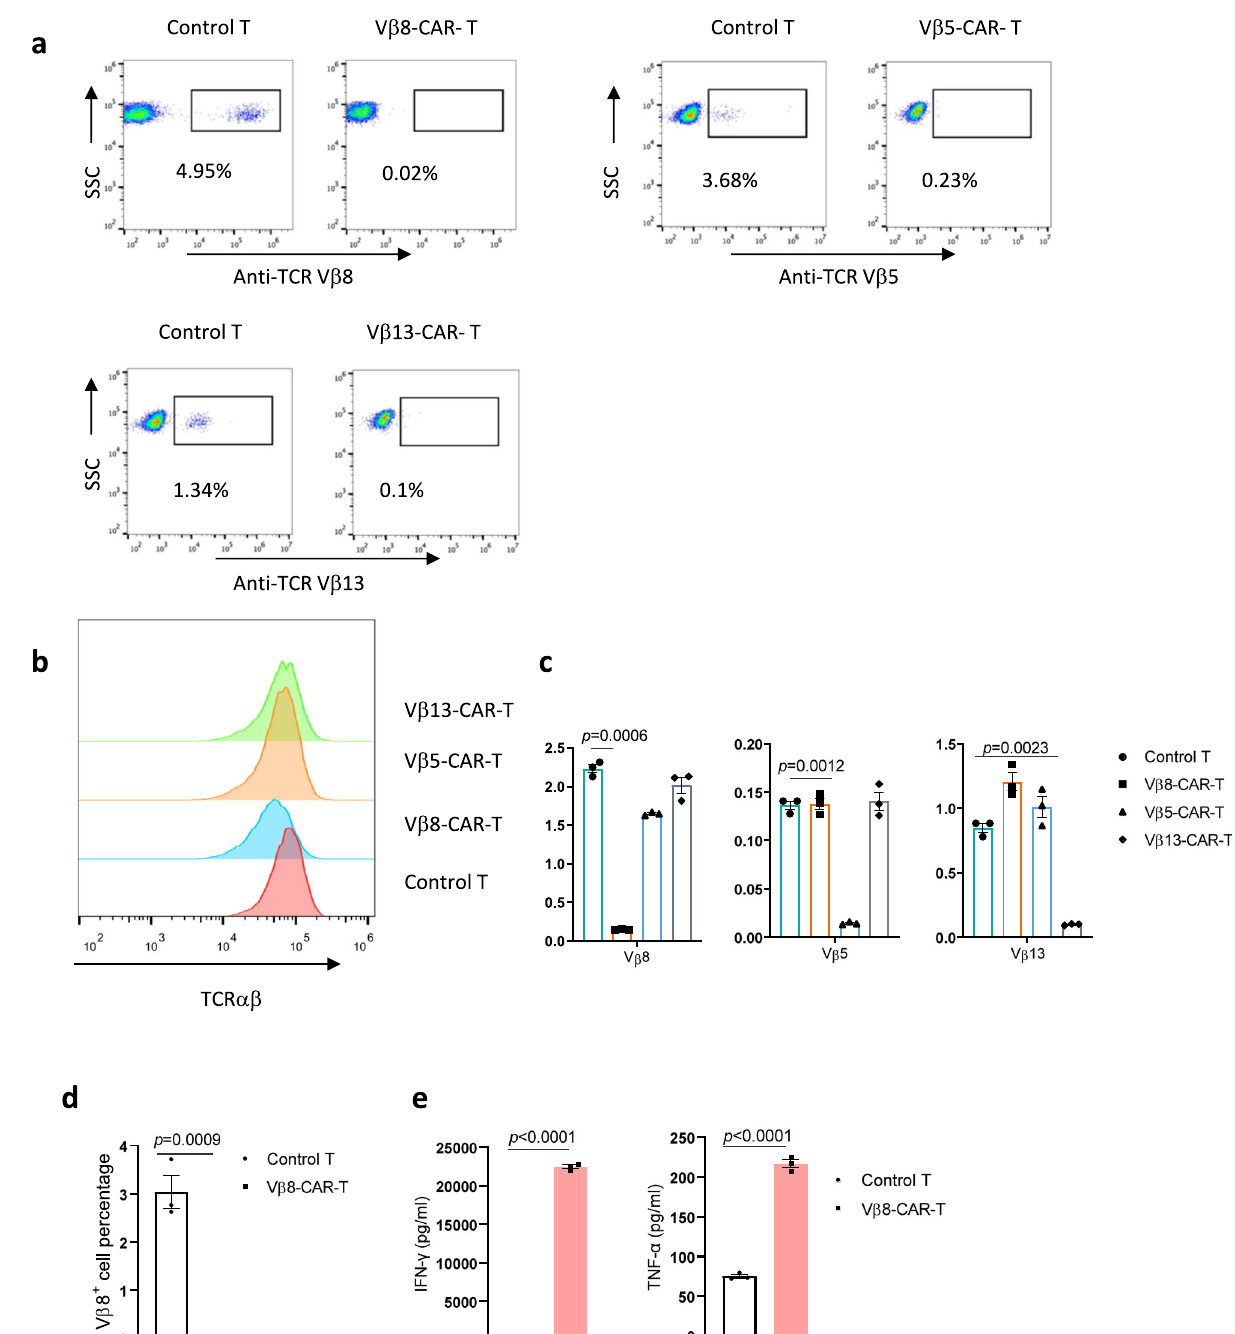
Fig. 1 | V β -speci fi c CAR-T cells speci fi cally eliminated target-positive primary T cells. a – c The expression levels of the indicated TCR V β subtypes ( a , c ) or total TCR αβ ( b )inuntransducedTcellsandV β 8-,V β 13-,orV β 5-speci fi